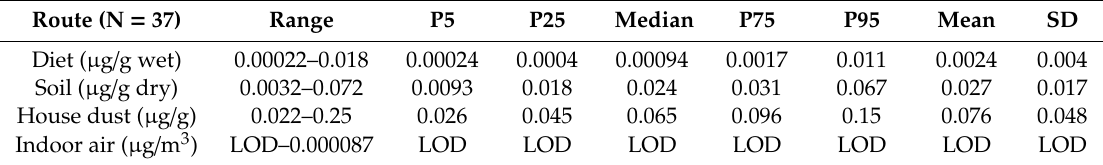
Table 1. Summary of Hg concentrations according to the exposure route.